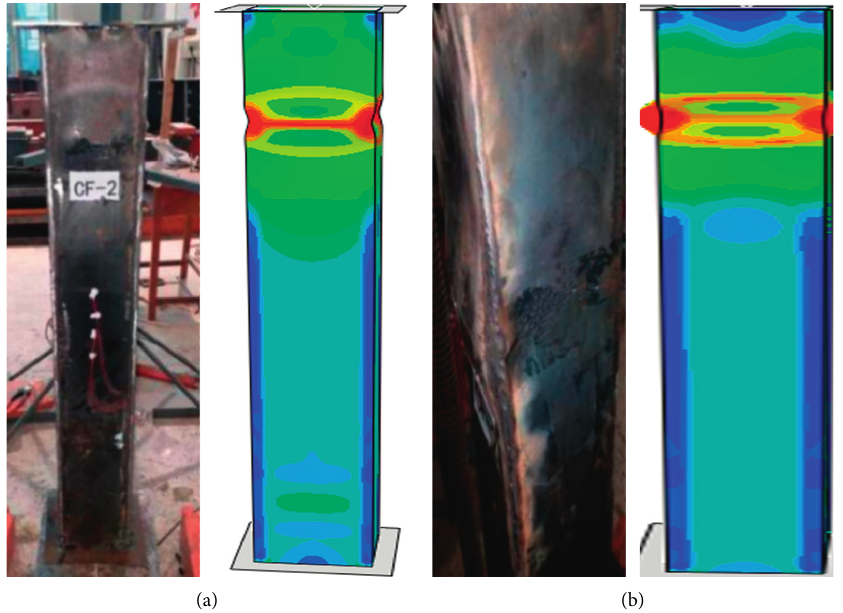
Figure 36: CF-type failure mode: (a) front elevation and (b) side elevation.